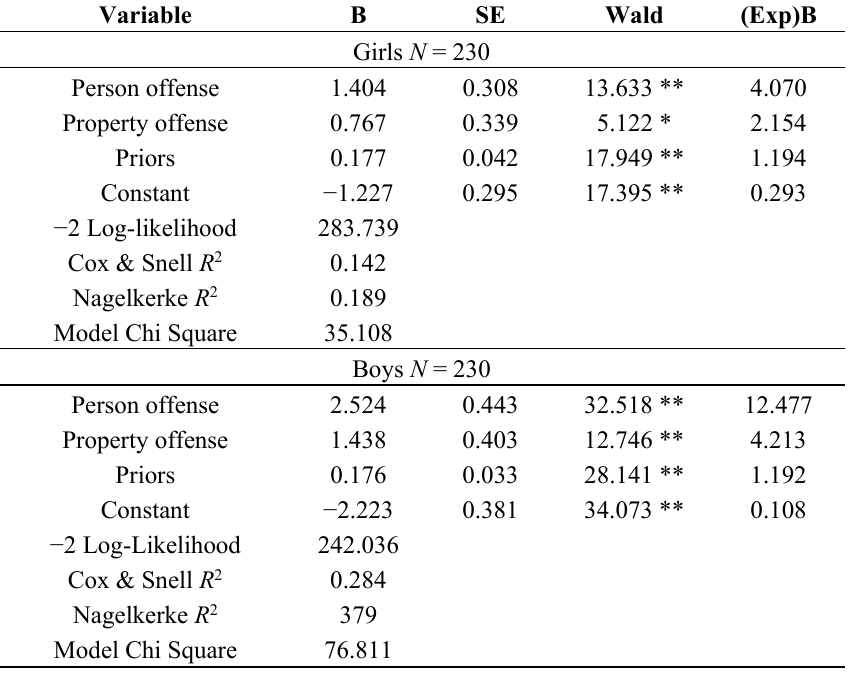
Table 3. Logistic Regression Results of Legal Variables for Girls and Boys.